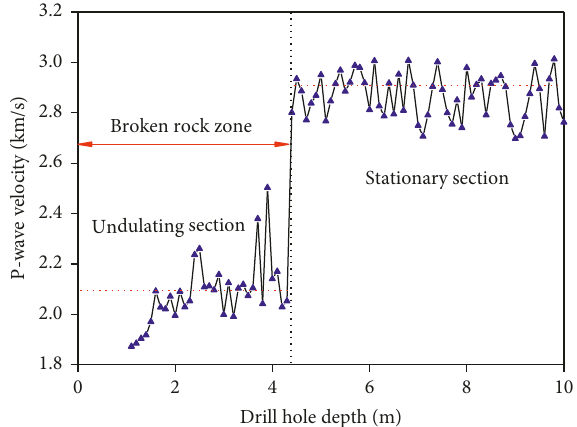
Figure 7: The relationship between the wave velocity and the depth of the drilling hole of the test point C.